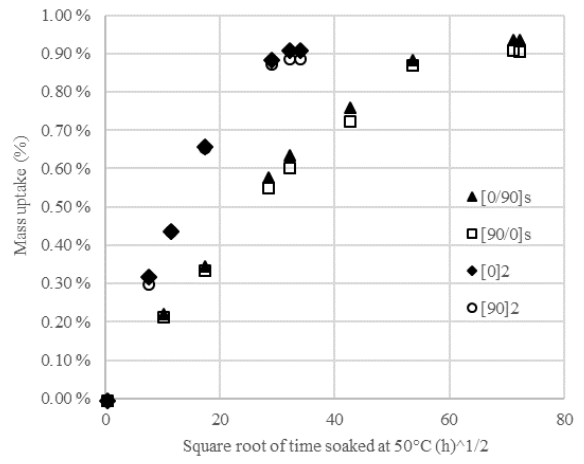
Figure 1. Moisture uptake